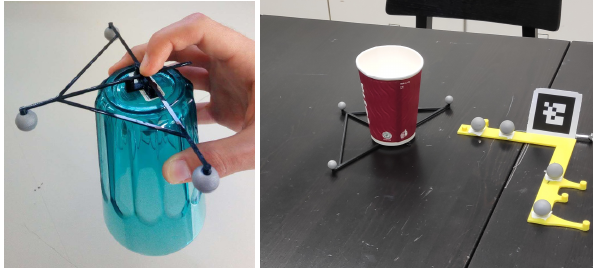
Figure 13. Object stand and table origin tool, both fitted with MoCap markers.